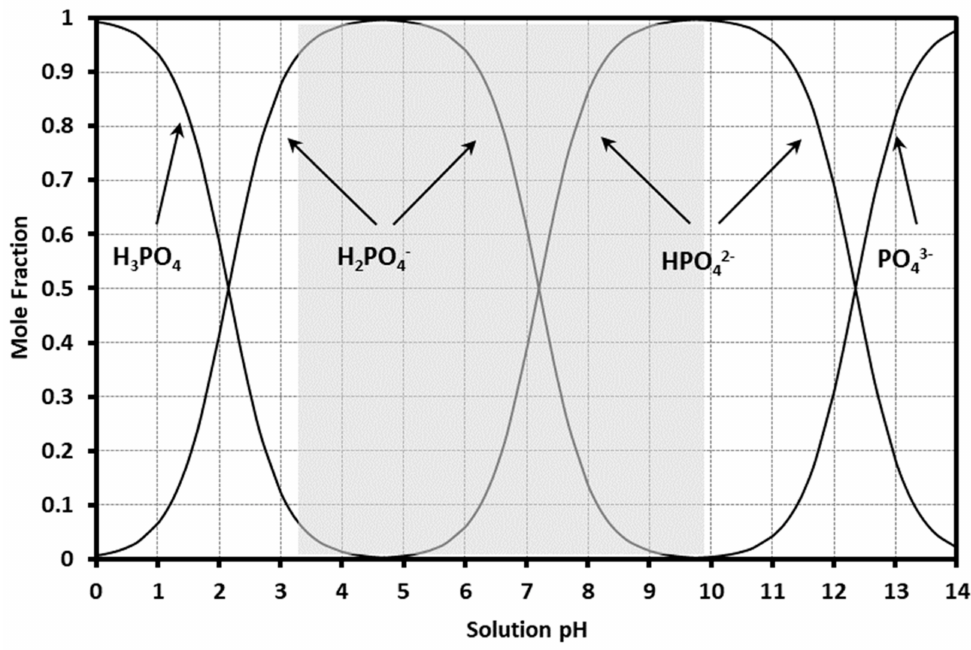
Figure 2. Distribution of phosphate species in water as influenced by pH. Shaded area represents normal range in soil